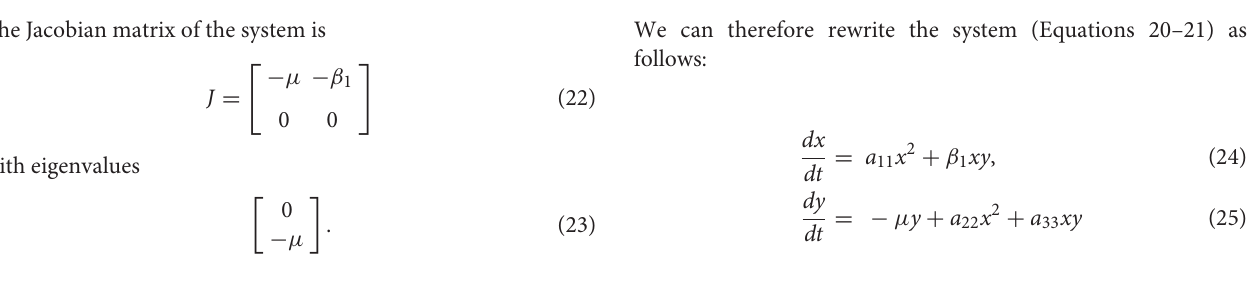
The Jacobian matrix of the system